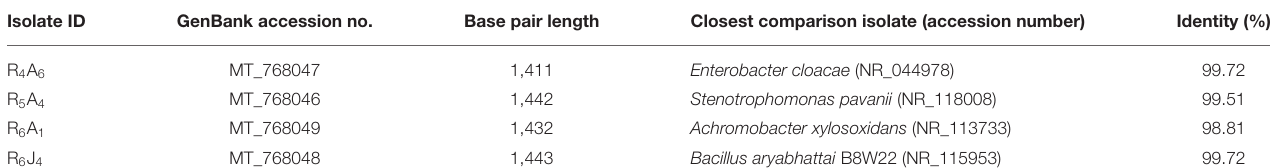
TABLE 1 | Identity profile of 16S rDNA gene partial sequence of four isolates according to BLAST identification.